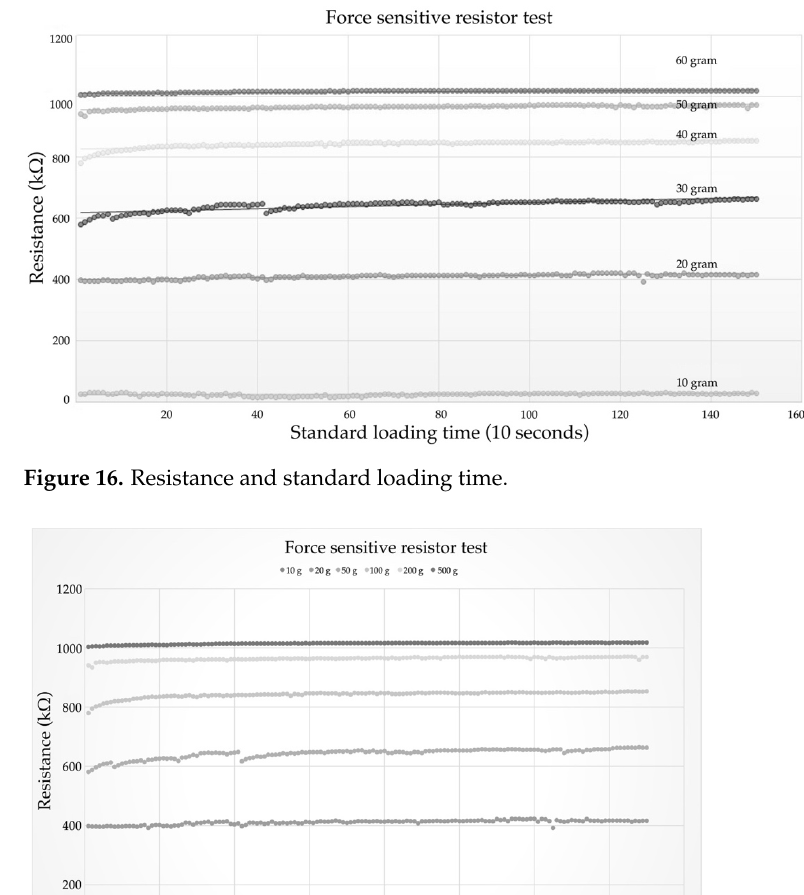
Table 6. Conductive force-sensitive resistor.